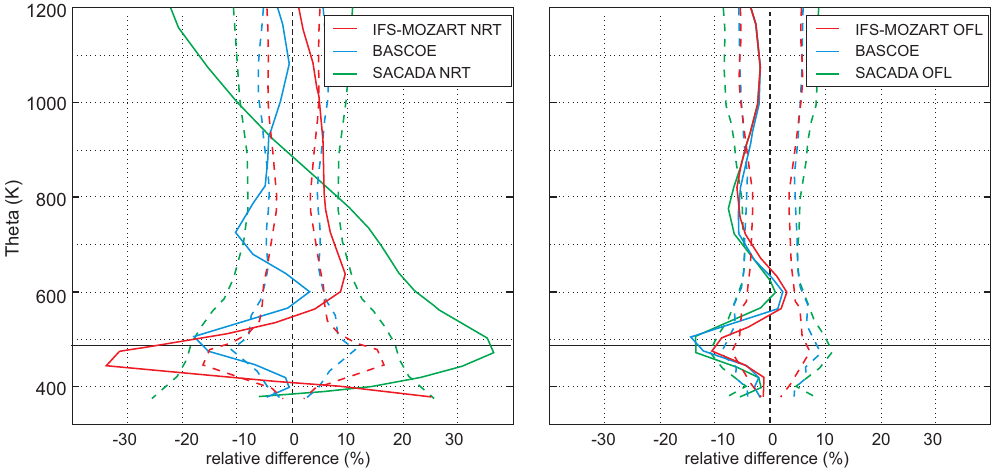
Figure 11. Mean bias and standard deviations, in %, of the differences between the NRT analyses (left) and the offline experiments (right) of IFS-MOZART, BASCOE, and SACADA, on the one hand, and ACE-FTS observations, on the other hand, within the North Pole vortex (vortex edge calculated with an sPV of > 1 . 7e − 4 s − 1 ) for March 2011. The ozone hole level used in Fig. 8 ( θ ∼ =485K) is indicated as the black horizontal line.